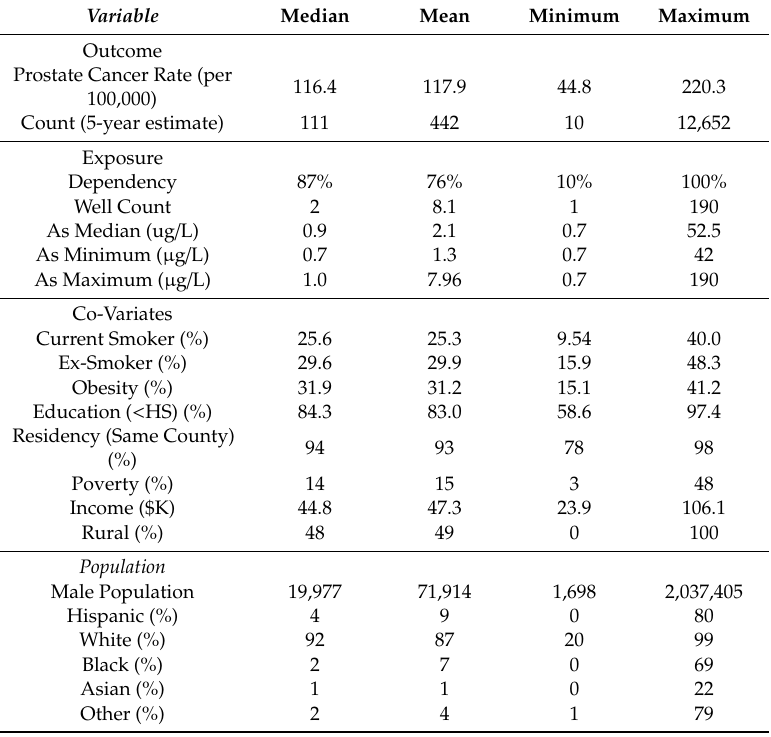
Table 1. Data Characteristics of Analytic Variables for 715 Individual